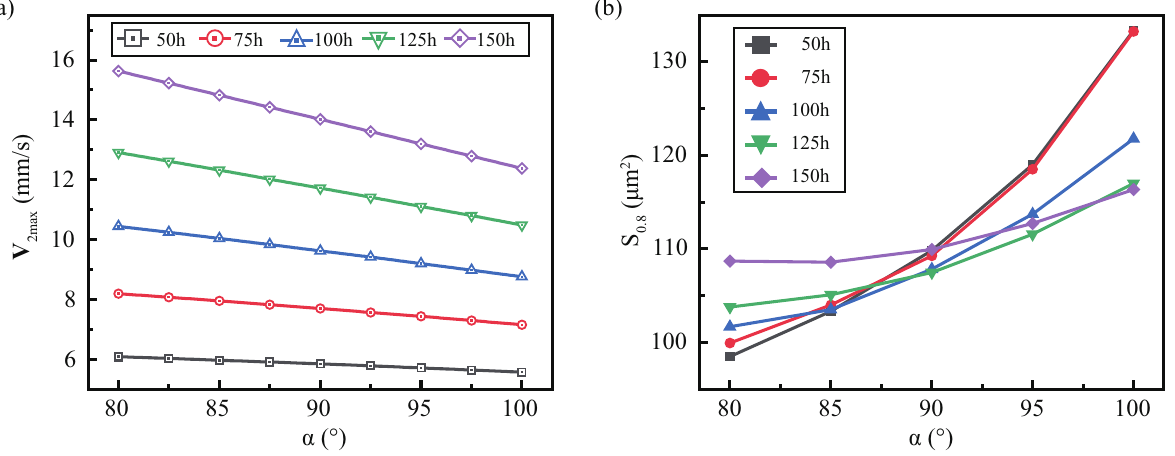
Figure 8. The effect of the sidewall angle under various h on the streaming: ( a ) maximum streaming velocity ( b ) effective area S 0.8 . Constant parameters: f = 10 kHz, η = 0.89 mPa ·